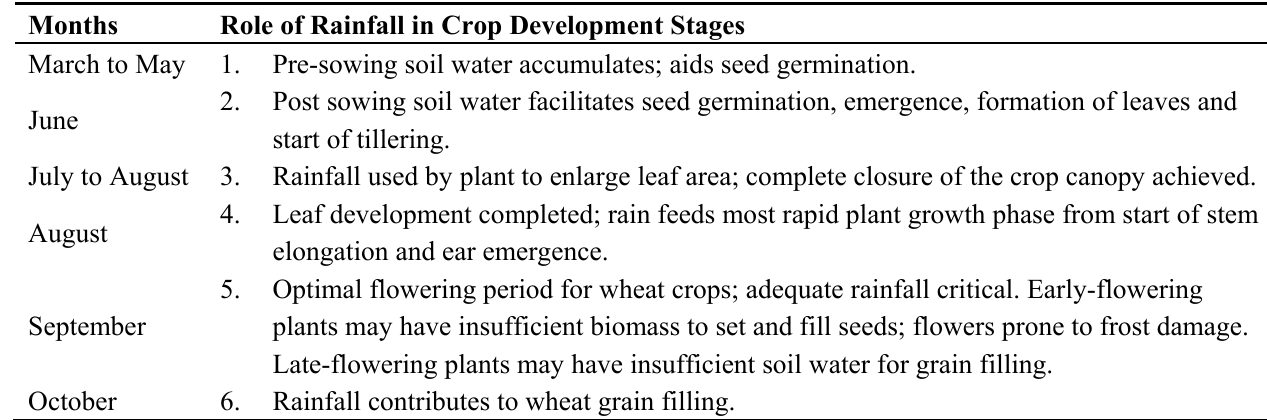
Table 1. The role of monthly rainfall in the growth of wheat